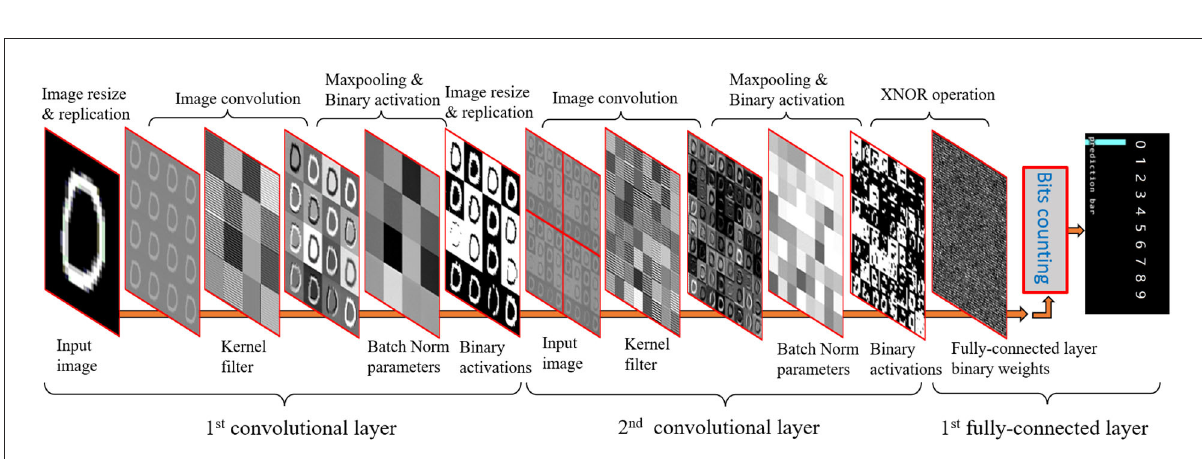
the given binary activations (Figure 6 top left) and weights (top right), which can be efficiently processed with the parallel bit operation on DREG. This figure shows the weights for